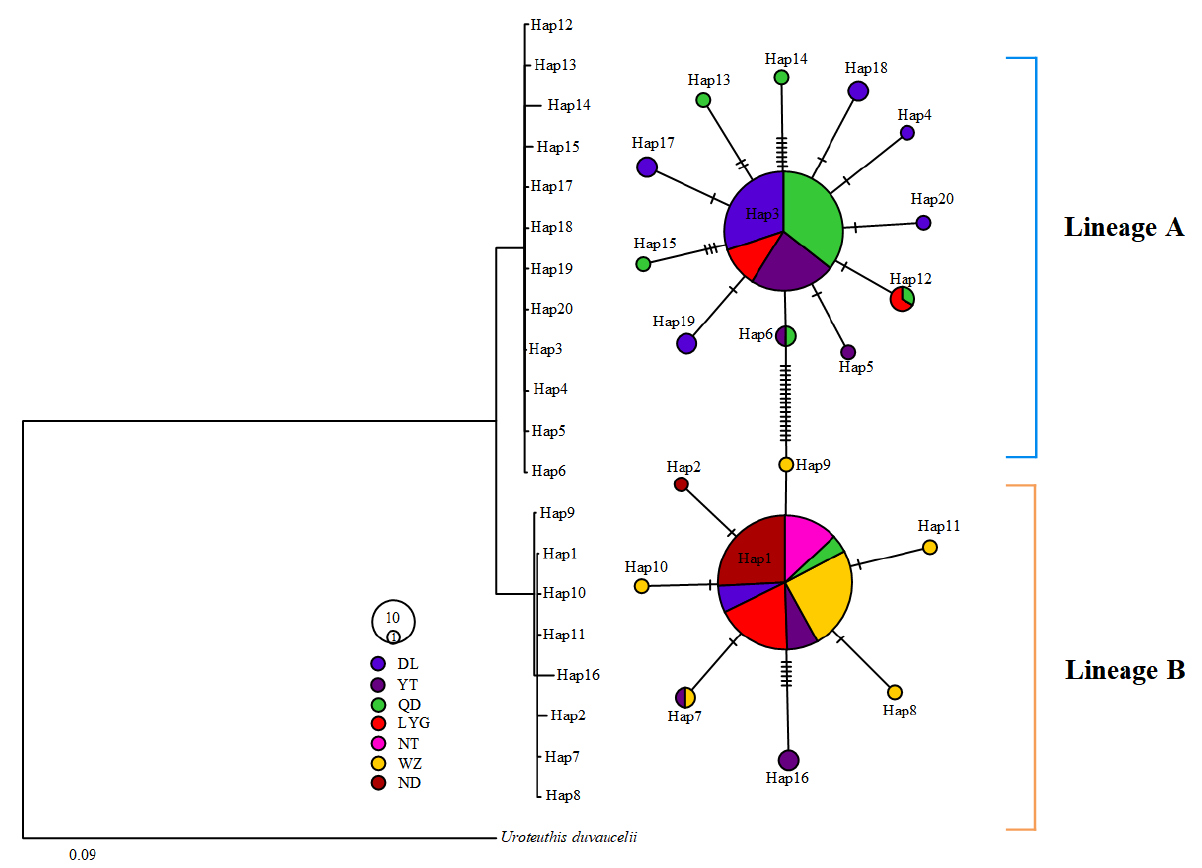
Figure 3. Maximum likelihood (ML) and Bayesian inference (BI) phylogenetic tree and haplotype network of L. ( N. ) beka based on 16S haplotypes. Size of circle is proportional to the frequency of a particular haplotype. Each small line on the line that connects two circles represents a mutational step, and black dots represent hypothetical missing intermediates.